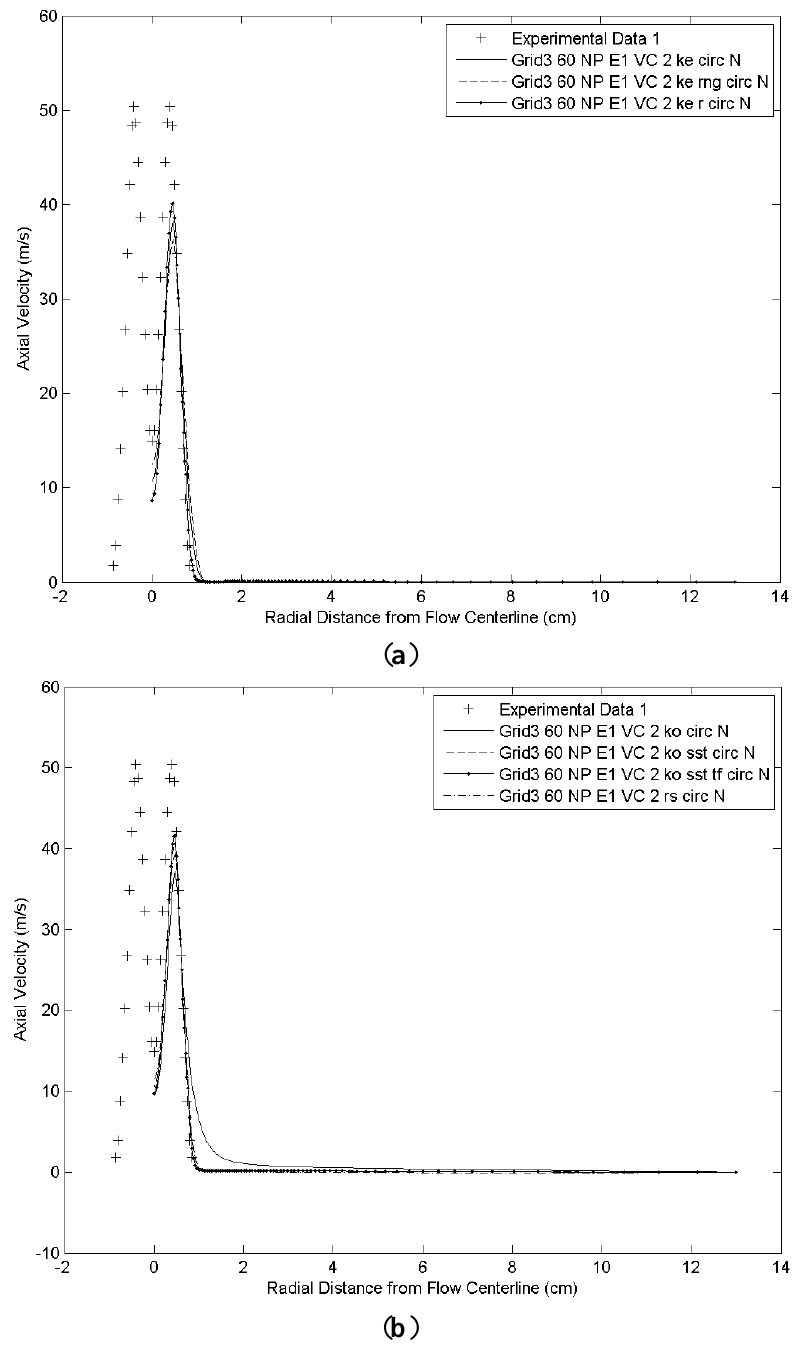
Figure 15. Comparison with experiment of results from ( a ) standard k -  (ke), k -  realizable (ke r) and RNG k -  (ke rng) models at z = 2.5 cm from the nozzle; ( b ) standard k -ω (ko), z = 2.5 cm from the